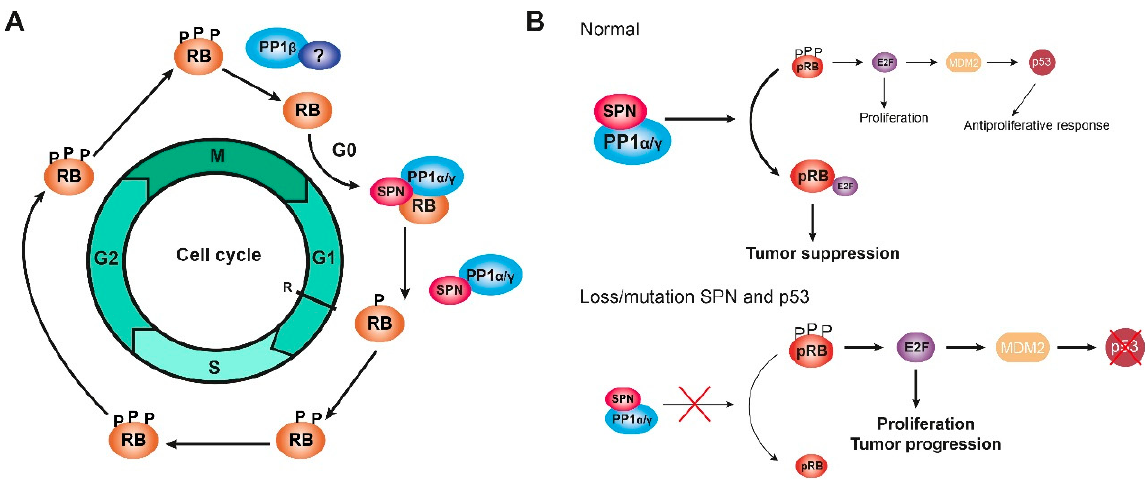
Figure 4. The holoenzyme PP1-SPN. ( A ) Scheme of the dephosphorylation of RB proteins (named here RB to refer to the three pocket proteins at the same time) during G1 by the holoenzyme PP1 α / γ -SPN. The dephosphorylation of RB proteins might be regulated by PP1 β in complex with an unknown regulatory protein during the end of mitosis. ( B ) Scheme of the mechanism of the holoenzyme PP1-SPN in tumorigenesis, comparing a normal situation (upper) and a tumoral situation in which SPN is lost/mutated, and p53 is mutated (bottom). Only when p53 is mutated, the loss/mutation of SPN can induce cell proliferation and tumor progression, evading the neutralizing response of p53. Figure adapted from [80,89,90].